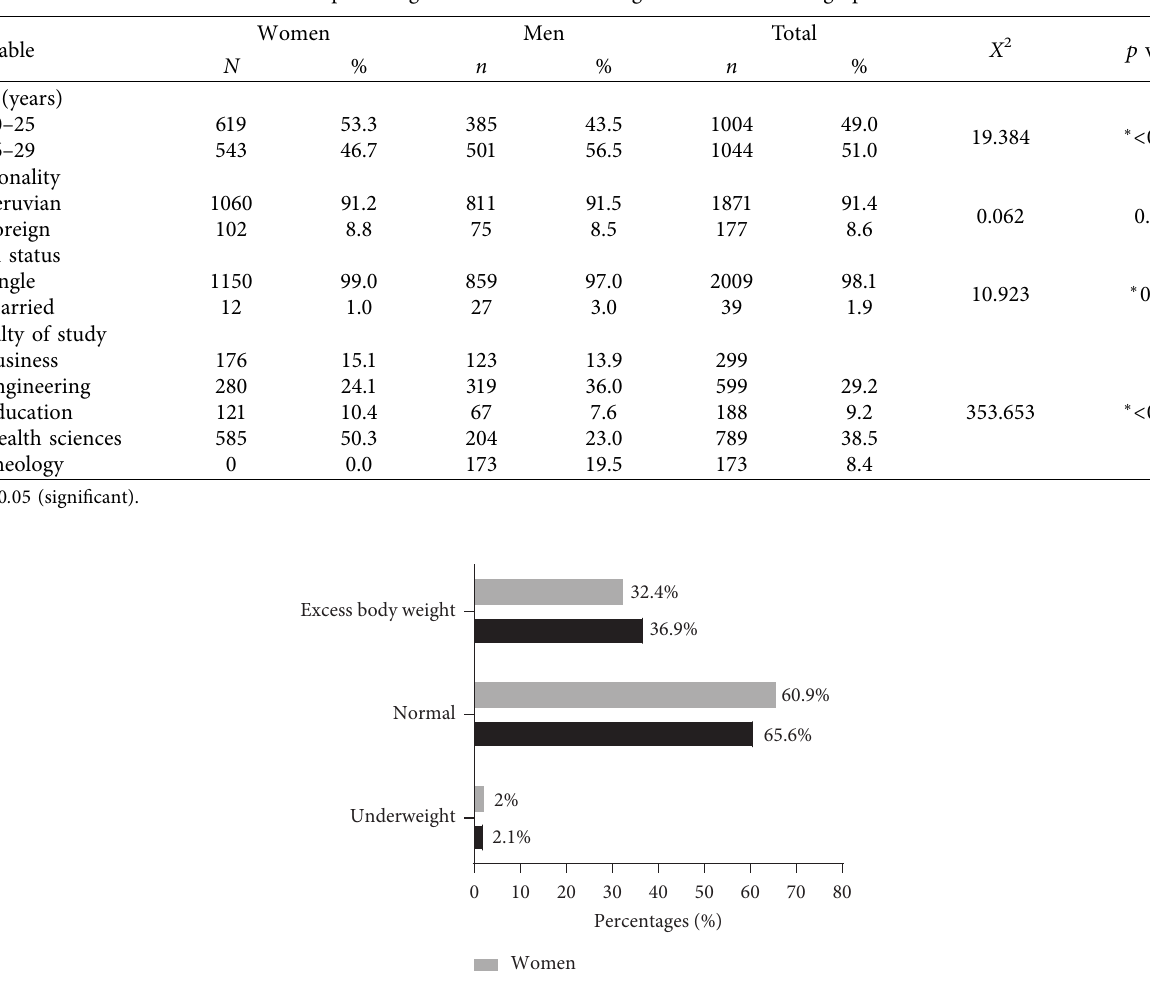
Table 1: Number and percentages of students according to their sociodemographic characteristics.